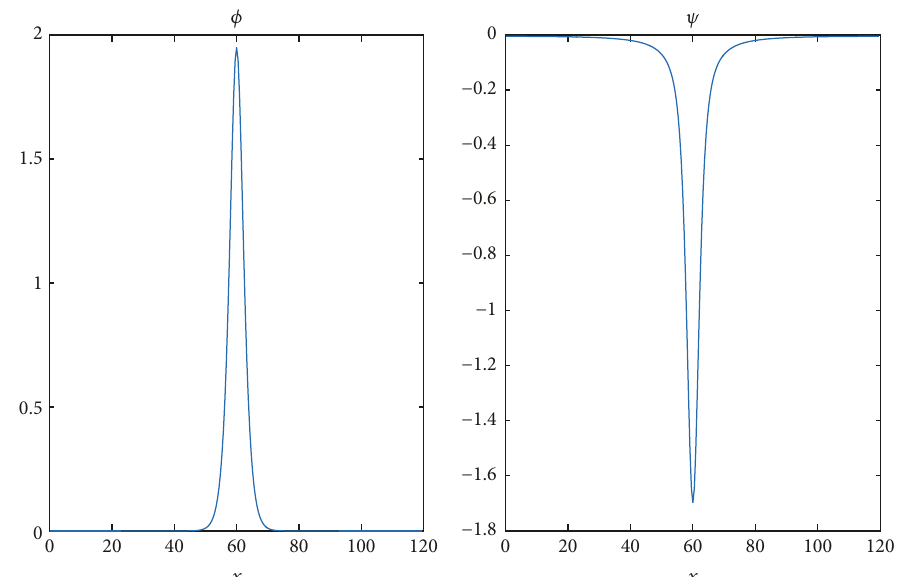
Figure 11: Approximations of 𝜙, 𝜓 in the solitary wave solution (39) with 6 Newton’s iterations. The model’s parameters are 𝛼 = 𝛽 = 0.4 , 𝛾 = −1 , 𝑤 = 0.5 , and wave speed 𝑐 = 0.5 .